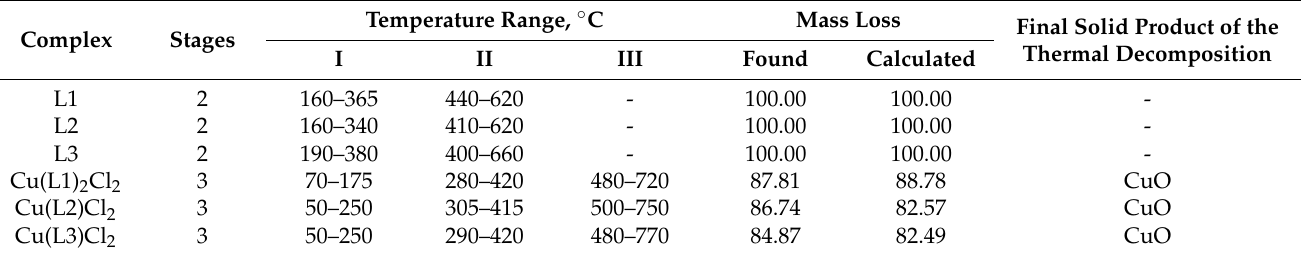
Table 3. Thermal decomposition data of L1, L2, L3, Cu(L1) 2 Cl 2 , Cu(L2)Cl 2 , and Cu(L3)Cl 2